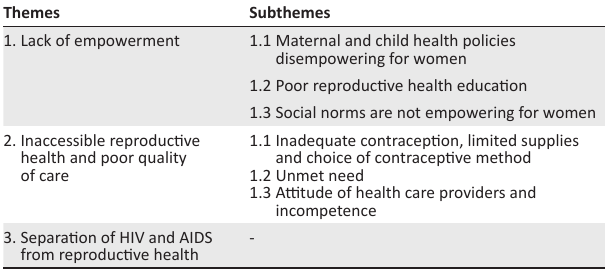
TABLE 3: Determinants of poor reproductive health outcomes by themes and subthemes.